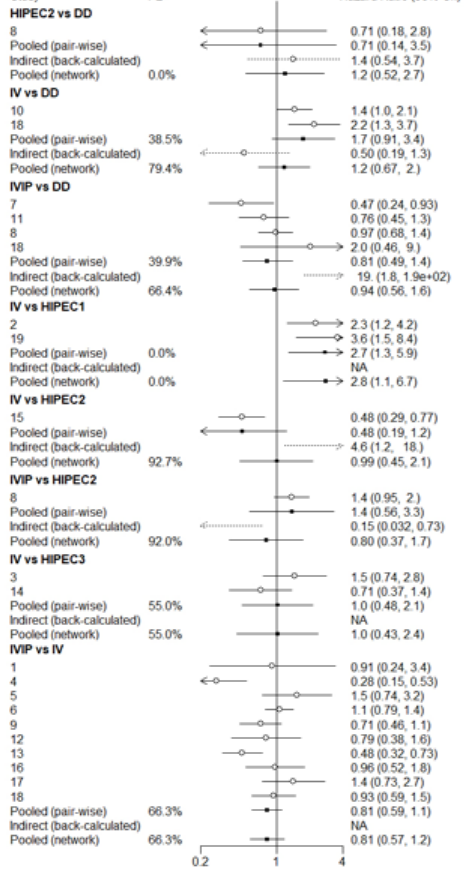
Figure A3. Forest plot of PFS (RCTs).